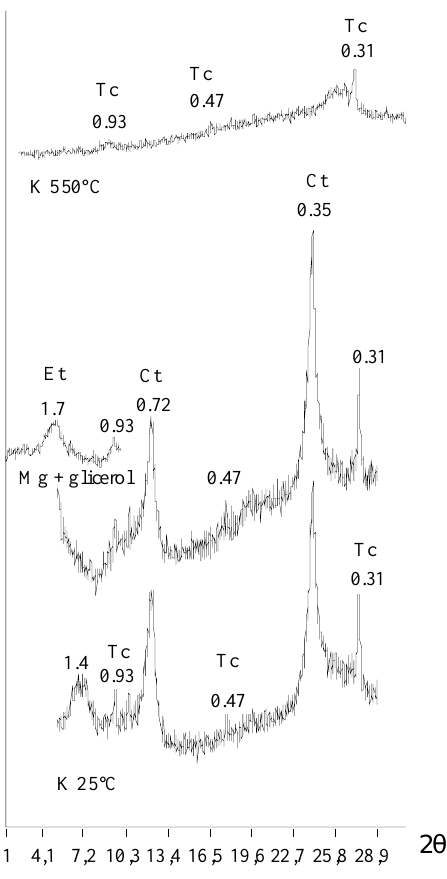
Figura 9. Difratogramas de raios-X da amostra 3C (Perfil 3 – MTf) com os diversos tratamentos. Espaçamento d em nm (Ct = caulinita, Tc = talco, Et =